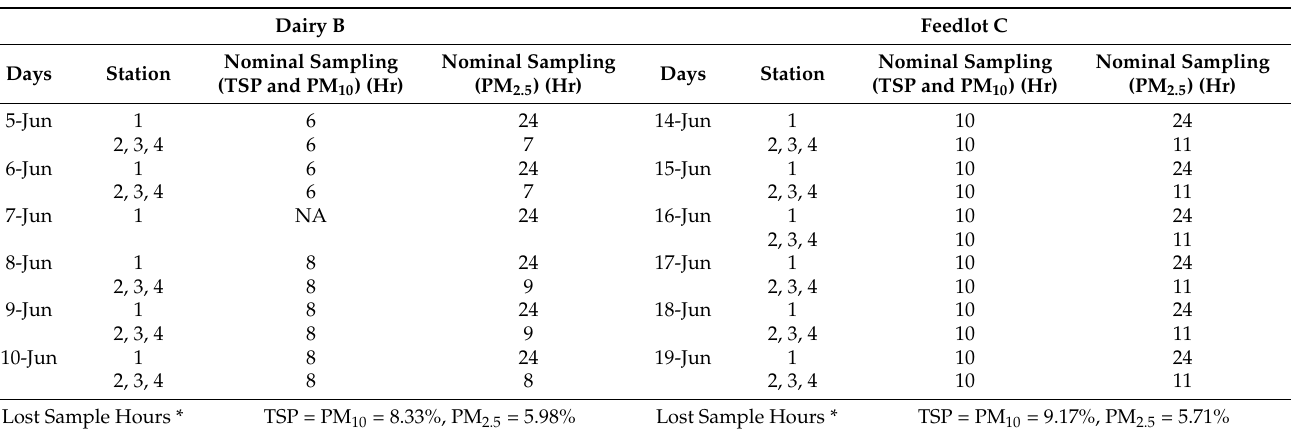
Table 1. Emission sampling schedule in 4 stations for both sampling sites (Station 1, 2, and 3 were in downwind position while station 4 was in upwind